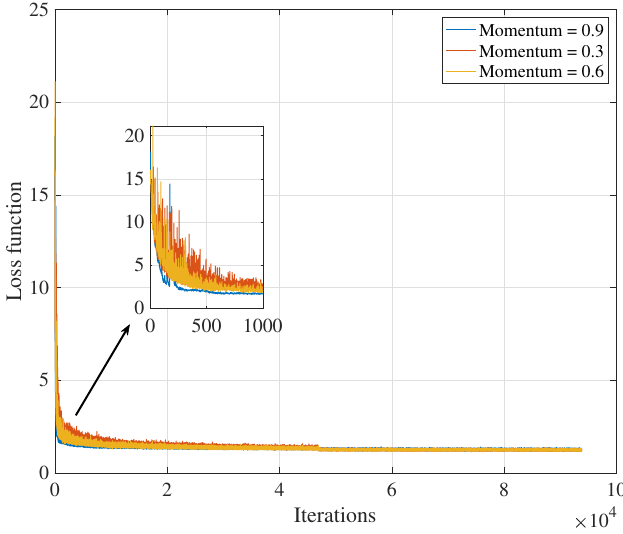
Figure 8. The loss function with different values of